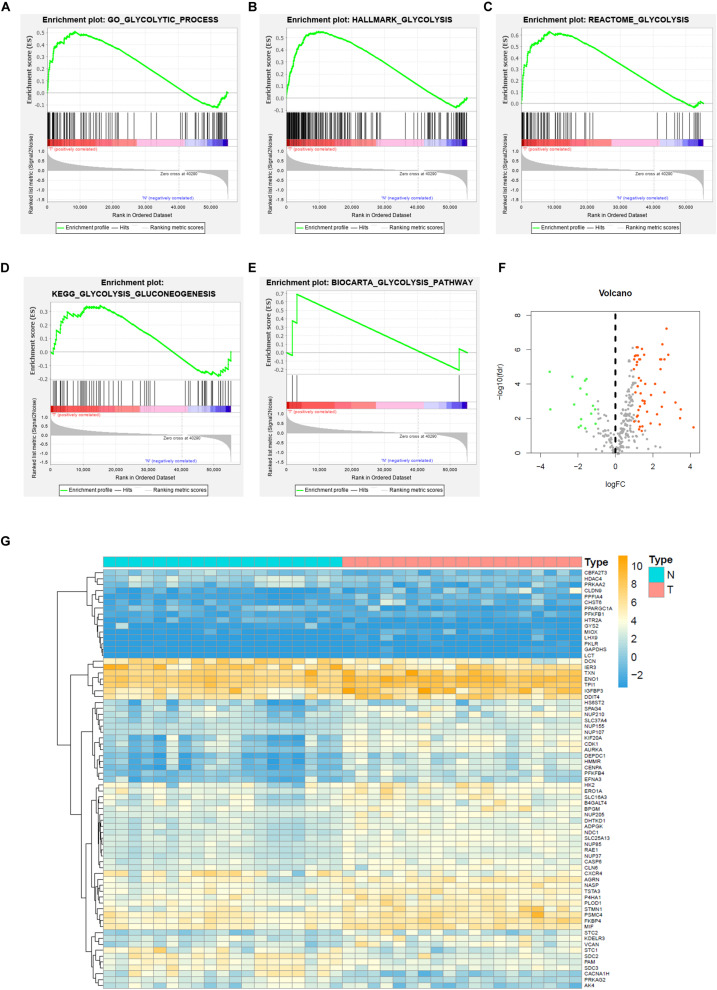
Gene set enrichment analysis (GSEA) and glycolysis-related DEGs of BC in TCGA. (A) GO_GLYCOLYSIS_PROCESS, (B) HALLMARK_GLYCOLYSIS, (C) REACTOME_GLYCOLYSIS, (D) KEGG_GLYCOLYSIS_GLUCONEOGENESIS, (E) BIOCARTA_GLYCOLYSIS_PATHWAY, and (F) Volcano plot of DEGs for TCGA dataset, and (G) Heatmap of GEGs for TCGA dataset.